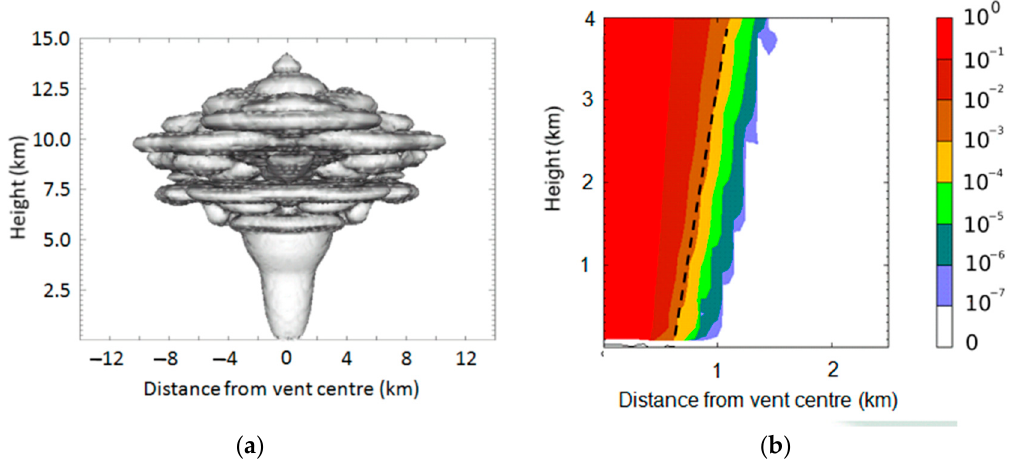
Figure 2. Structure of plume at t = 1200 s. ( a ) An isosurface of constant arbitrary concentration; ( b ) ejection column showing concentration (colour shaded; arbitrary units). In ( b ) a dashed line represents a distance / height gradient of 0.11.